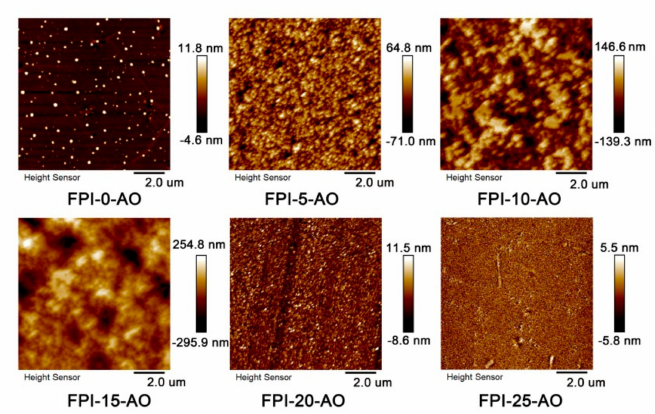
Figure 15. The 2D AFM images (10 µ m × 10 µ m) of PI films after AO exposure (4.0 × 10 20 atom / cm 2